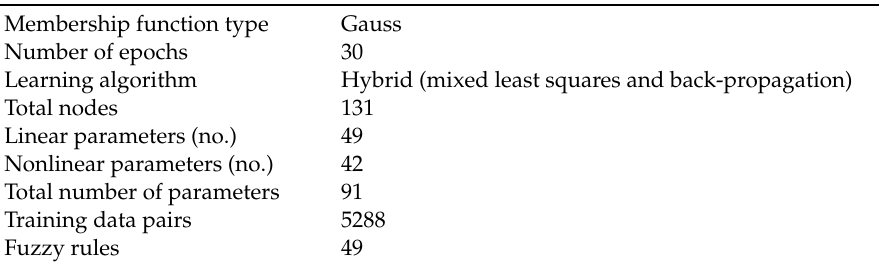
Figure 6. ANFIS model structure. Table 3. ANFIS parameters.